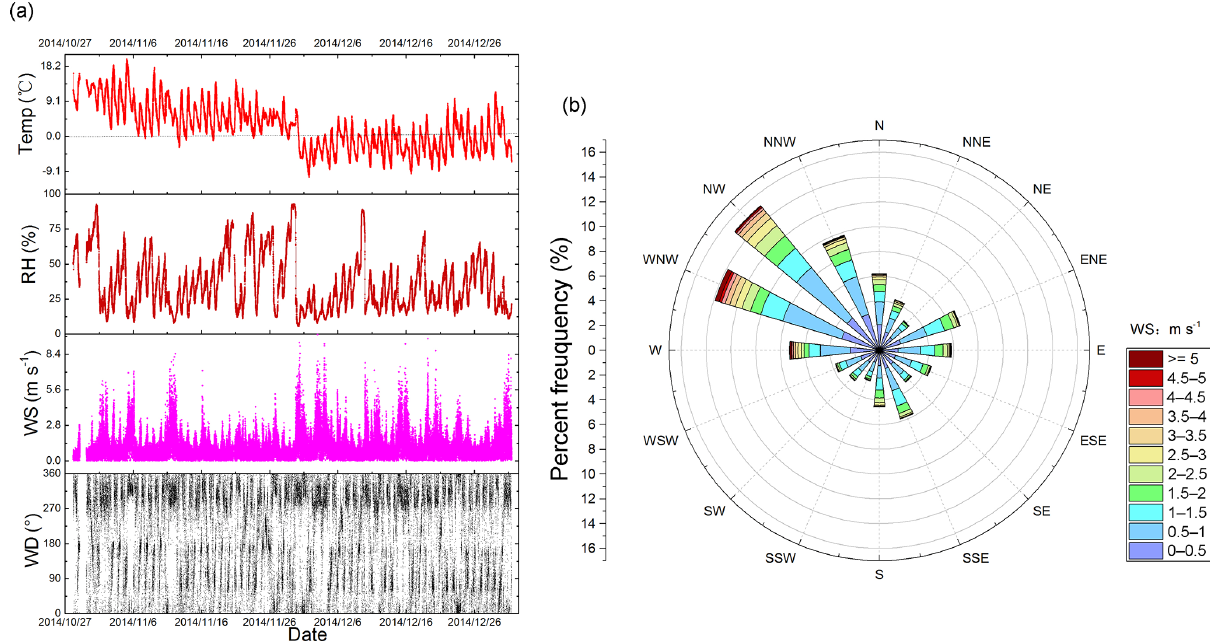
Figure 4. (a) Time series of the meteorological parameters with a time resolution of 1min containing ambient temperature, relative humidity (RH), wind speed (WS), and direction (WD). (b) Wind rose. Data obtained during the period of 28 October to 31 December 2014. Table 2. Parameter settings used for spectral analysis using WINDOAS, where x indicates the cross section used in the retrieval. Parameter Data source Fitting interval: nm 335–360nm (HCHO) 338–360nm (NO 2